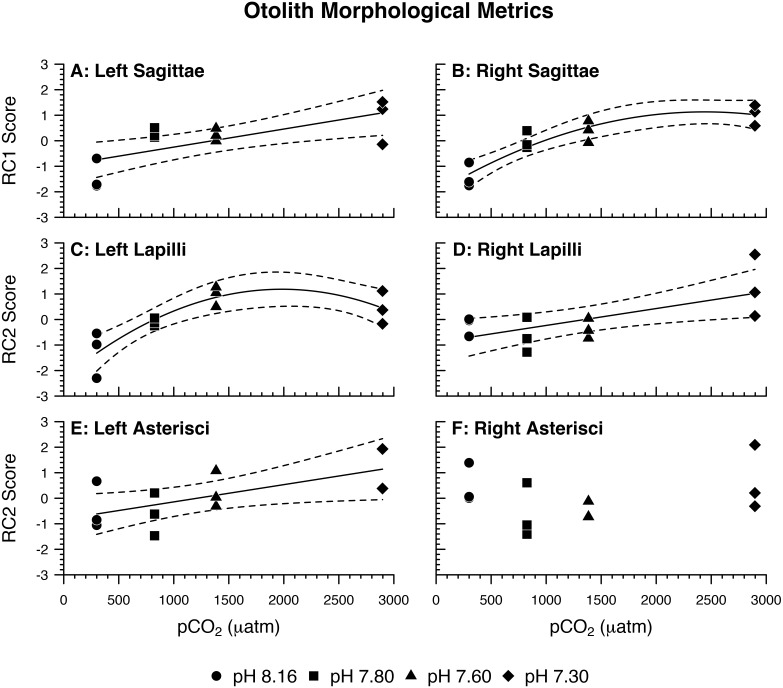
Otolith morphological metrics.Regression lines (solid) and 95% confidence bands (dotted) represent significant relations between pH/pCO2 treatment (legend) and (A, B, C, D, E) rotated component (RC) scores representing Amphiprion clarkii otolith morphological variables, grouped by otolith type and side (A, p = 0.0061; B, p = 0.0004; C, p = 0.0045; D, p = 0.0168; E, p = 0.0420). Right asterisci components vs. pCO2 did not yield significant relations, but RC2 scores are plotted for illustrative consistency. Data points represent aquaria. N = 12, n = 3 except where (E) no data is available for an aquarium (N = 11, n = 2 for pH 7.30 treatment only). See Table 3 for otolith morphological variables and corresponding PCA loadings.